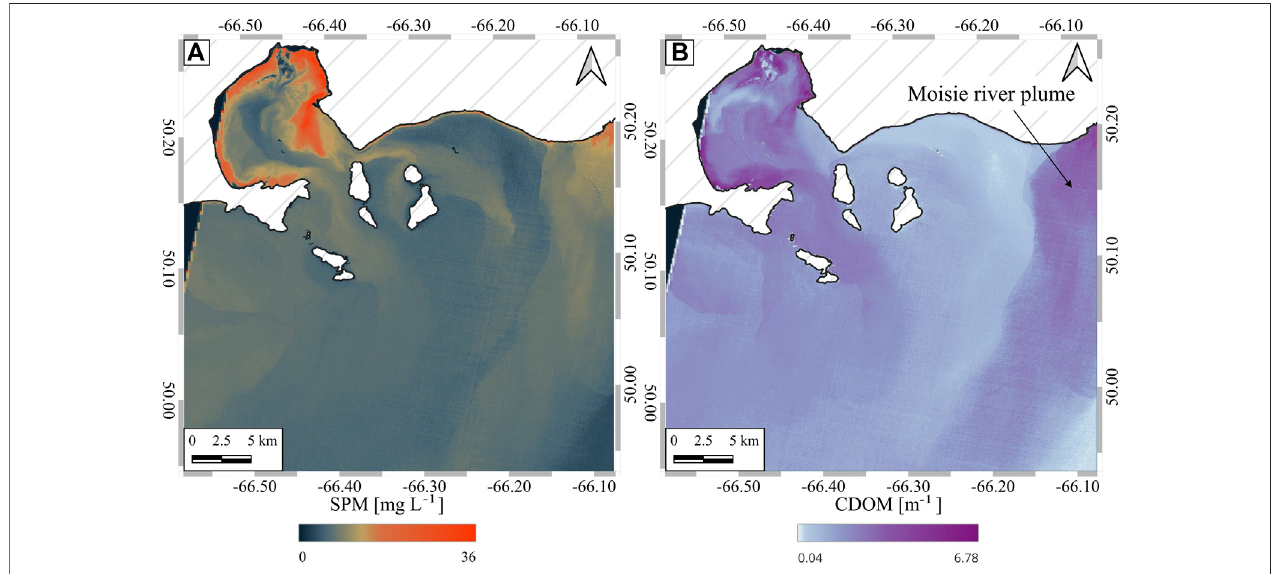
FIGURE12| MapofSPM (A) andCDOM (B) intheSept-Îlesbayretrievedfromthe17/05/2017Sentinel-2MSIimageafteratmosphericcorrectionwiththeC2RCC processor.